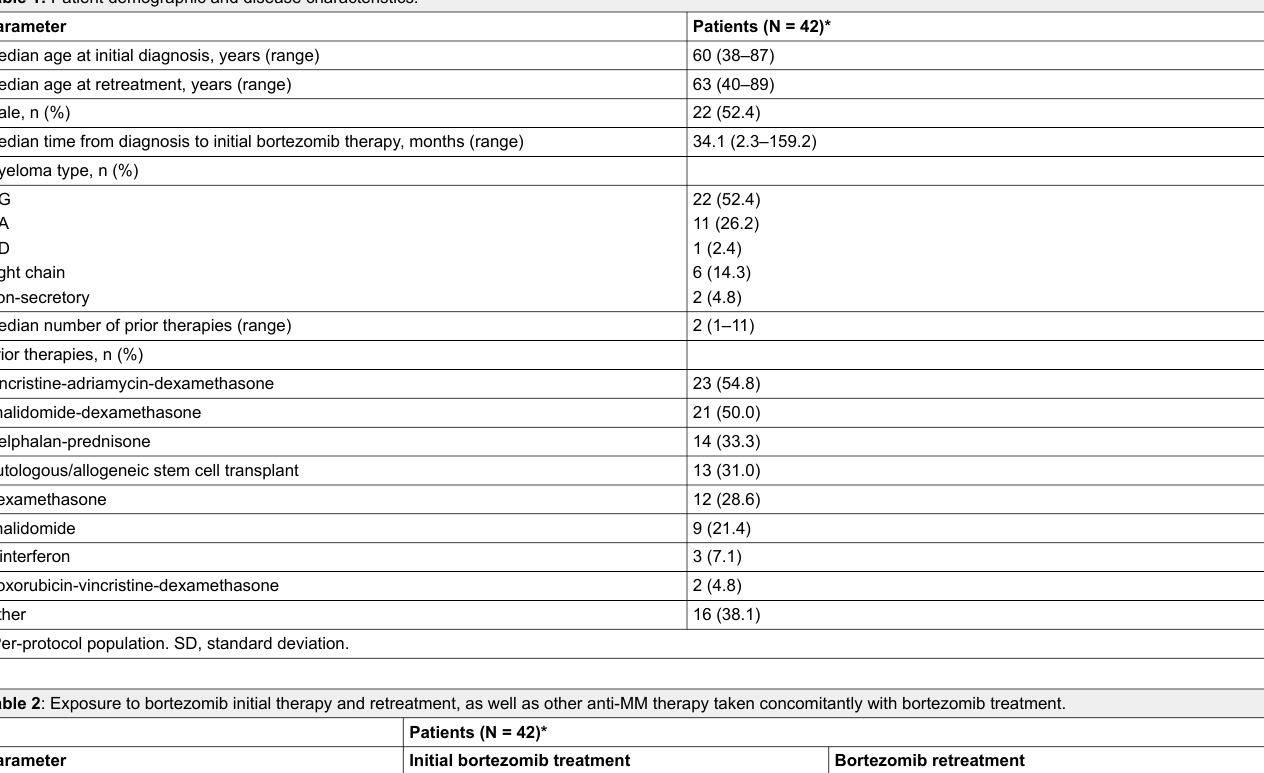
Table 1: Patient demographic and disease characteristics. Parameter